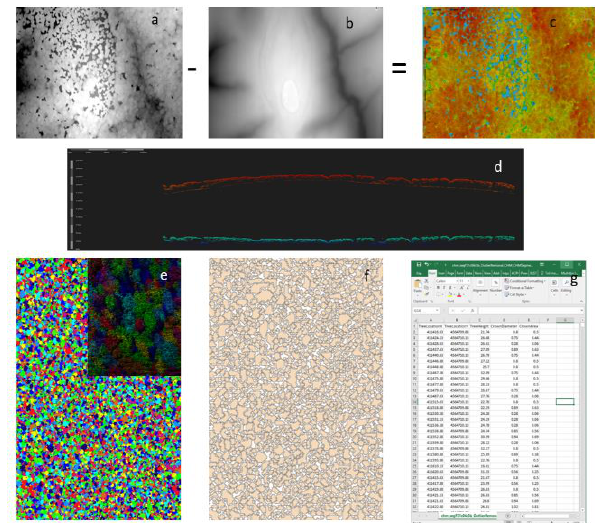
Figure 4. a. DSM, b . DEM, c . CHM, d . nCHM Profile, e . Segmentation result with TreeID, f . Vectorize segmentation result, g . Tabular data extract from LIDAR